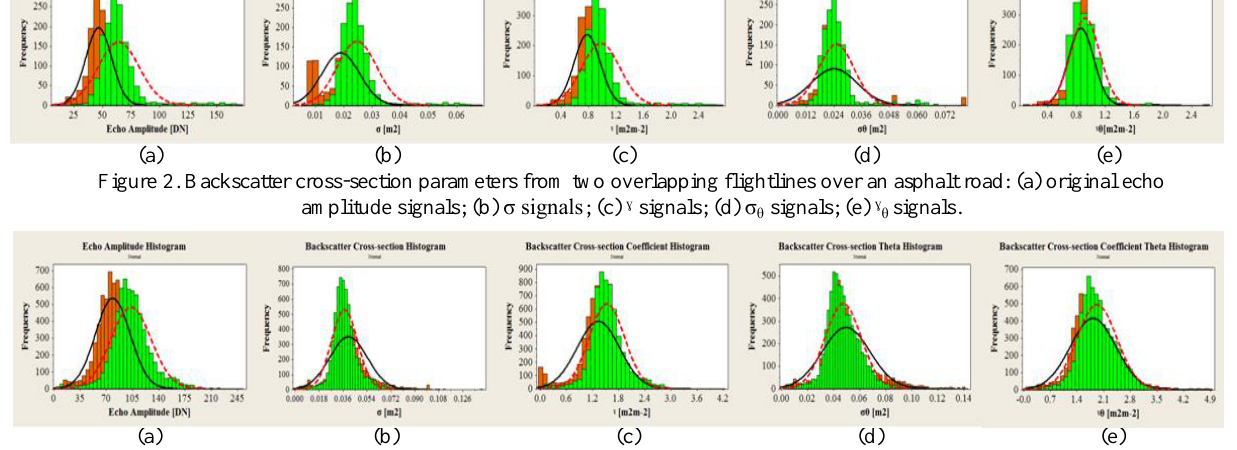
Figure 3. Backscatter cross-section parameters from two overlapping flightlines over complex roof surface: (a) original